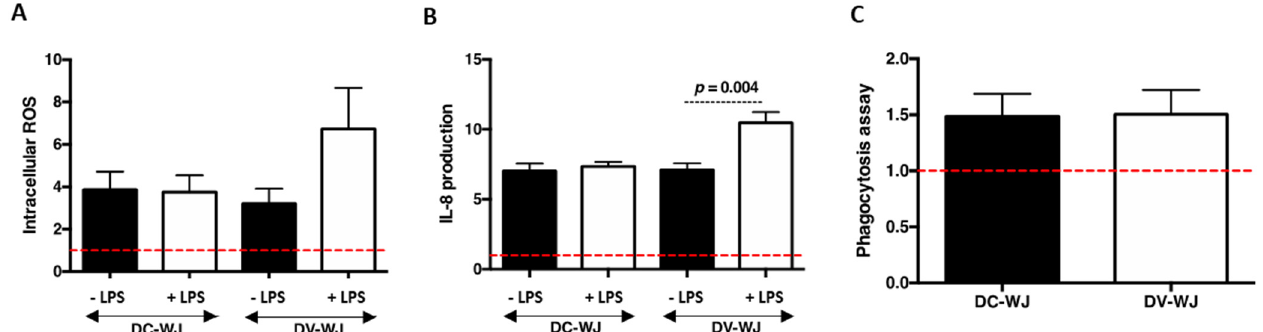
Figure 4. Innate neutrophil responses to decellularized and devitalized Wharton’s Jelly. ( A , B ): Intracellular accumulation of ROS in neutrophils and IL-8 production by neutrophils in the presence of DC-WJ and DV-WJ. ( C ): Median fluorescence intensity of phagocyted Bioparticles. All the results were normalized to the basal production of neutrophils indicated by red dashed lines; n = 4, Wilcoxon-Mann-Whitney test.